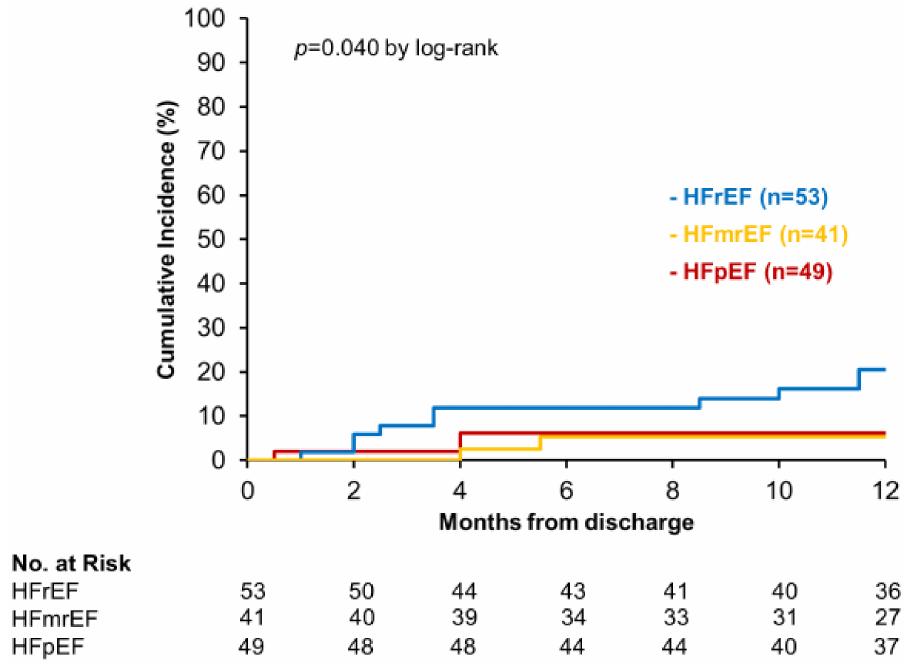
Figure 3. Recurrent hospitalization for heart failure in patients with heart failure stratified by LVEF